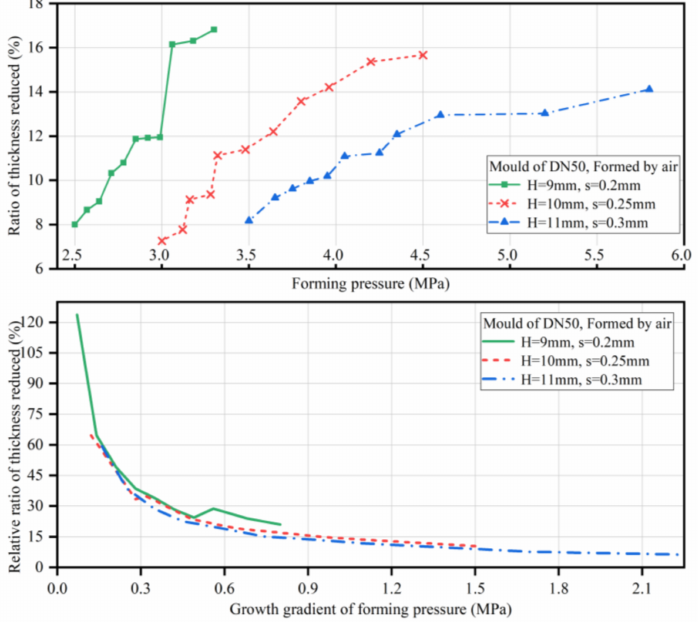
Figure 15. Absolute and relative ratios of thickness reduction for Dn 50 mm rupture discs formed by